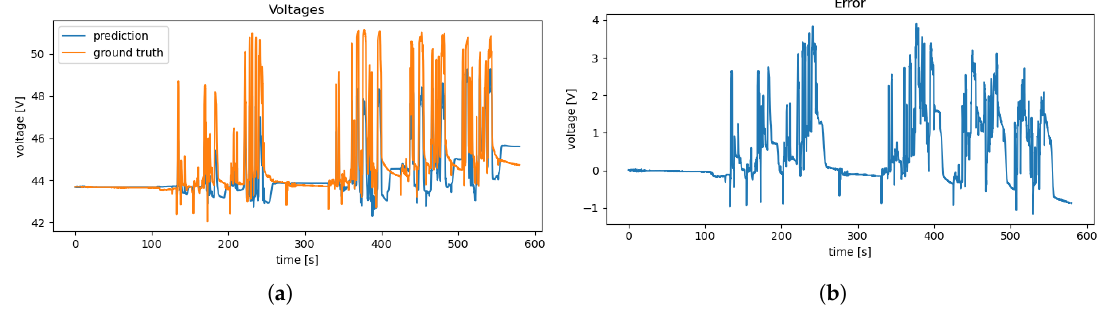
Figure 7. Voltage ( a ) and error ( b ) validation result for a current profile at − 23 °C and a SOC range from 30% to